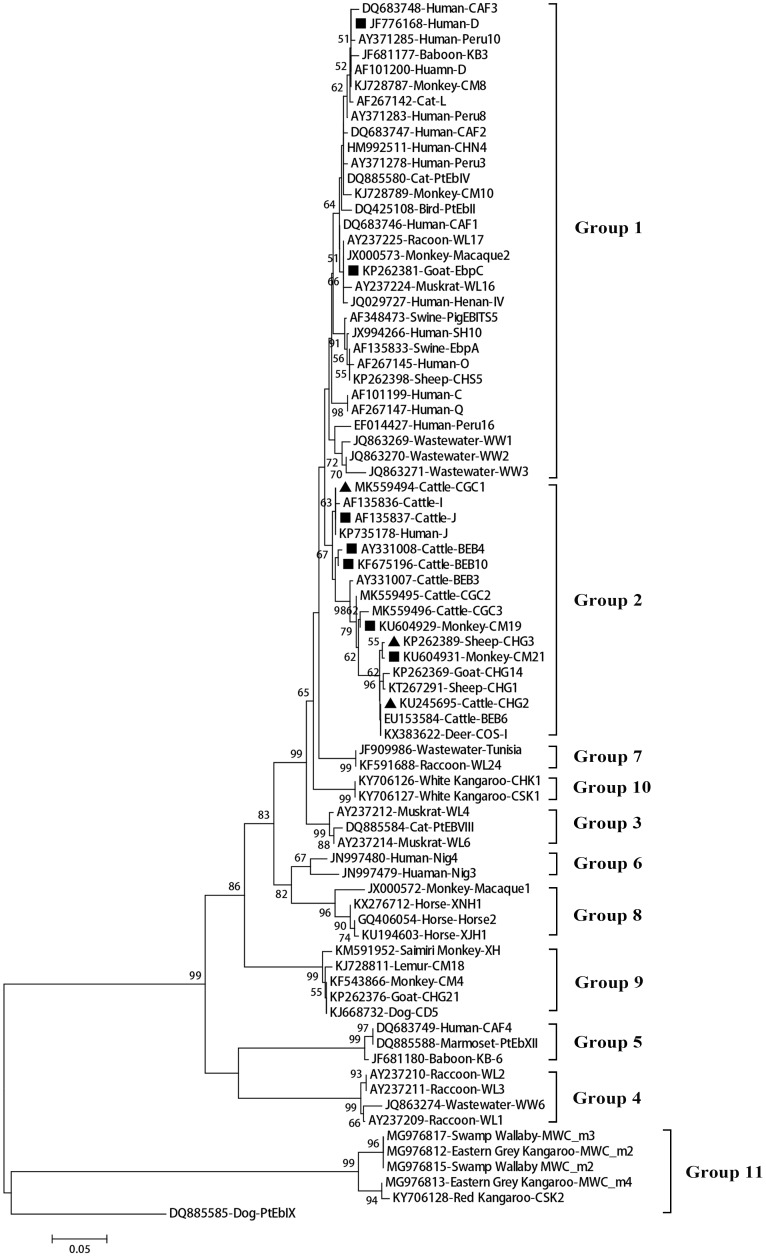
Phylogenetic relationships among the E. bieneusi genotypes identified in this study and other reported genotypes. The phylogeny was inferred from the Neighbor-joining (NJ) analysis of the ITS sequences based on the distances calculated using the Kimura 2-parameter model. Bootstrap values of N > 50% from 1,000 replicates are shown at the nodes. Known and new genotypes are indicated by hollow and filled triangles, respectively.